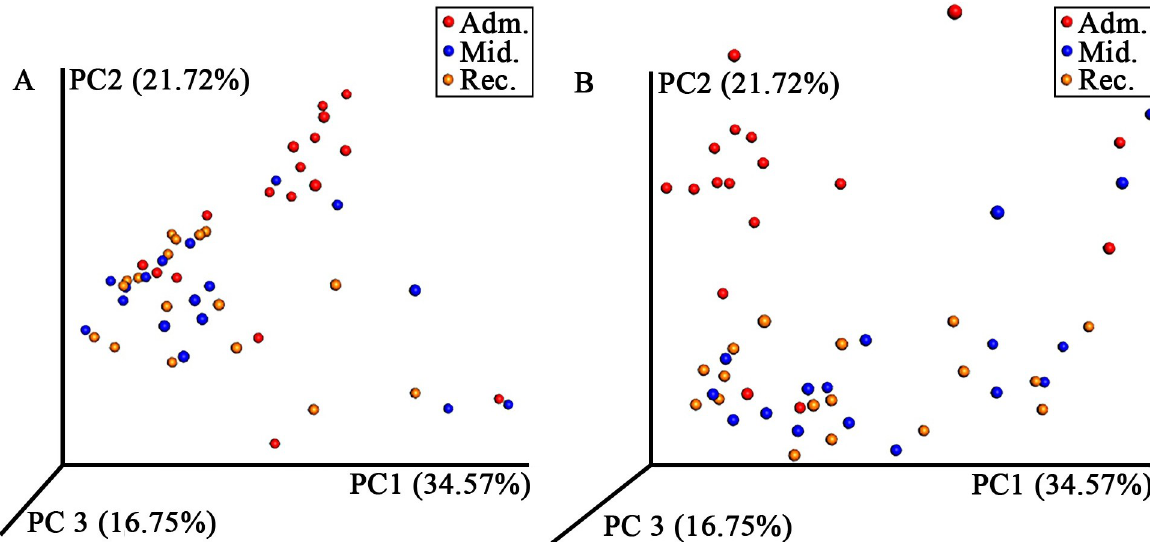
Fig 3. Juvenile green turtle fecal bacterial community composition across three time points in rehabilitation. Principle coordinate analysis of weighted (A) and unweighted (B) UniFrac distances of 16S rRNA genes found in feces from juvenile green turtles ( Chelonia mydas ) at various time points during rehabilitation (red = admission, blue = mid-rehabilitation, and yellow = recovery). Each circle represents an individual fecal sample. Composition at admission was significantly different from mid-rehabilitation (A: R = 0.121, p = 0.006; B: R = 0.258, p = 0.001). Composition at admission was also significantly different from recovery (A: R = 0.222, p = 0.001; B: R = 0.323, p = 0.001). Bacterial composition at mid- rehabilitation and recovery were not significantly different (A: R = -0.022, p = 0.713; B: R = -0.017, p =